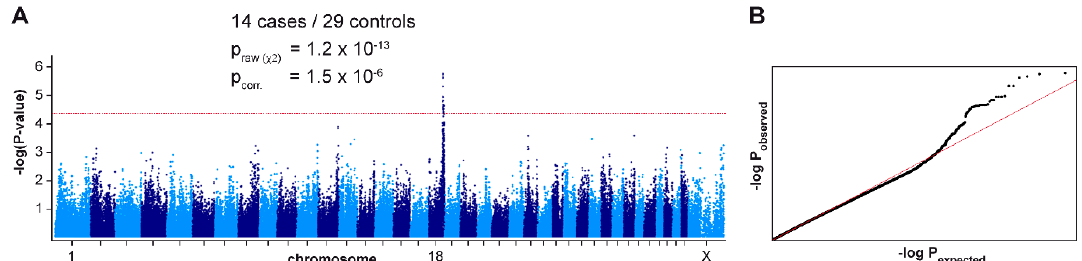
Figure 2. Mapping of the ECLE locus by genome-wide association. ( A ) Manhattan plot illustrating a single signal on chromosome 18. The dashed red line indicates the threshold for suggestive significance at p = 5 × 10 − 5 according to [29]. The best associated marker did not reach the stringent Bonferroni significance threshold ( p Bonf. = 4.3 × 10 − 7 ) due to several close relationships and extreme genomic inflation in the dataset. The genomic inflation factor was 1.90 before and 0.99 after the correction. ( B ) The quantile – quantile (QQ) plot shows the observed versus expected – log( p ) values. The straight red line in the QQ plot indicates the distribution of p-values under the null hypothesis. The deviation of p -values at the right side indicates that these markers are stronger associated with the trait than would be expected by chance. This supports the biological significance of the association.